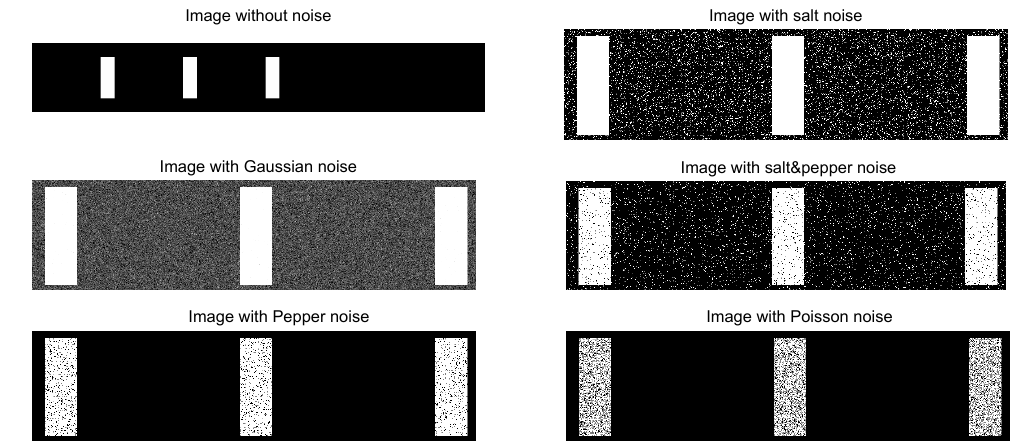
Figure 5. Synthetic images with different types of